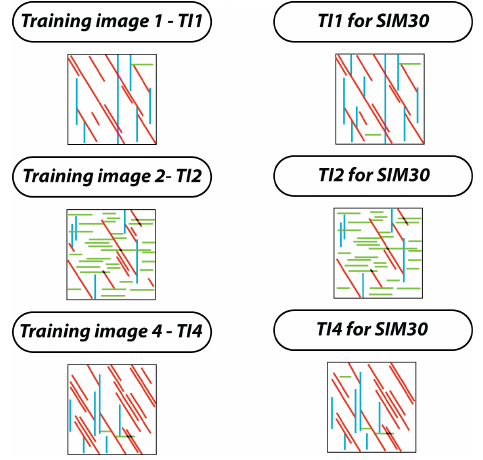
Figure 9. Comparison of training images 1, 3 and 4 used during the sensitivity analysis (27 simulations) and their modification for SIM